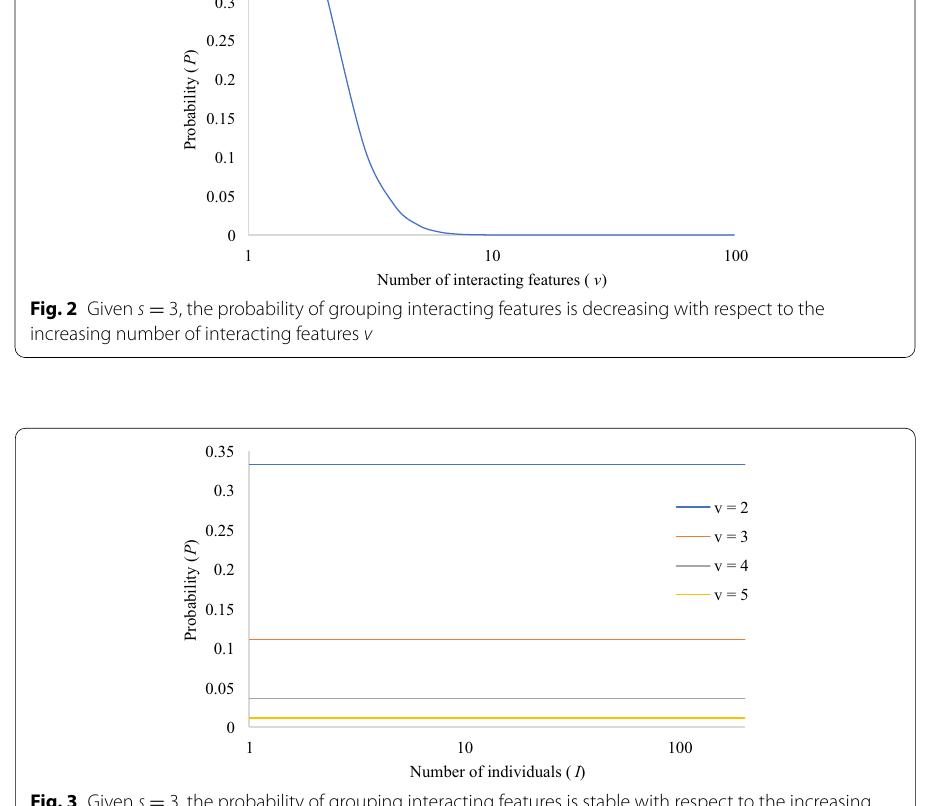
It can be observed from the graph that since in RFG-1, the features are grouped randomly only once at the beginning of an evolutionary process, the probability of grouping 9 features tends to zero irrespective of the number of individuals. However, if the number of interacting features is small, the probability of grouping is large, which is independent of the number of individuals shown in Fig. 2. The figure shows that when the number of interacting features is about 10, the probability of grouping these features into a single subcomponent is nearly zero. The probability of grouping interacting features randomly into a single subcomponent in term of the number of individuals in any generation of an evolutionary process is shown in Fig. 3. It can be seen that since the features are grouped randomly only once at the beginning of the evolutionary process, for any number of interacting variables, the probability will not be changed. For example, whether the number of individuals is 0 or 100, for v probability remains the same.